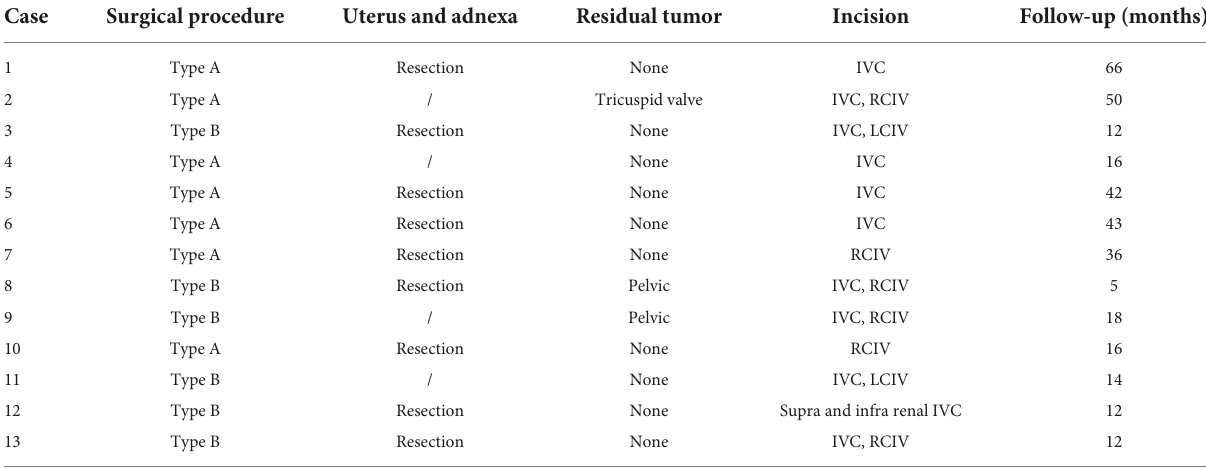
TABLE 2 Surgical procedures and outcomes.